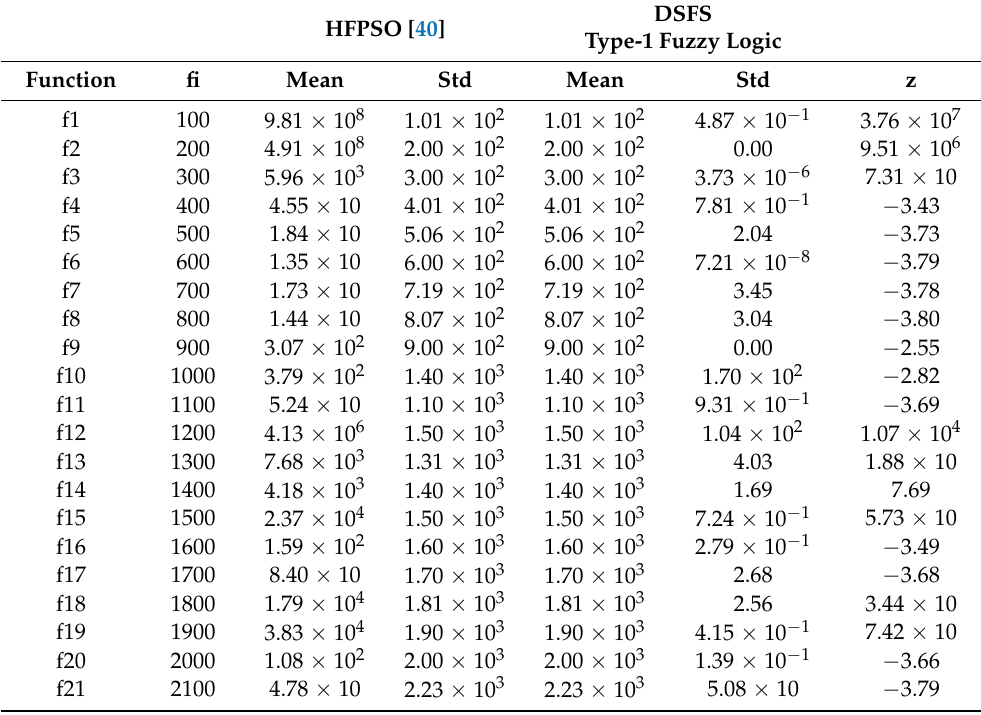
Table 8. Z-test for 10